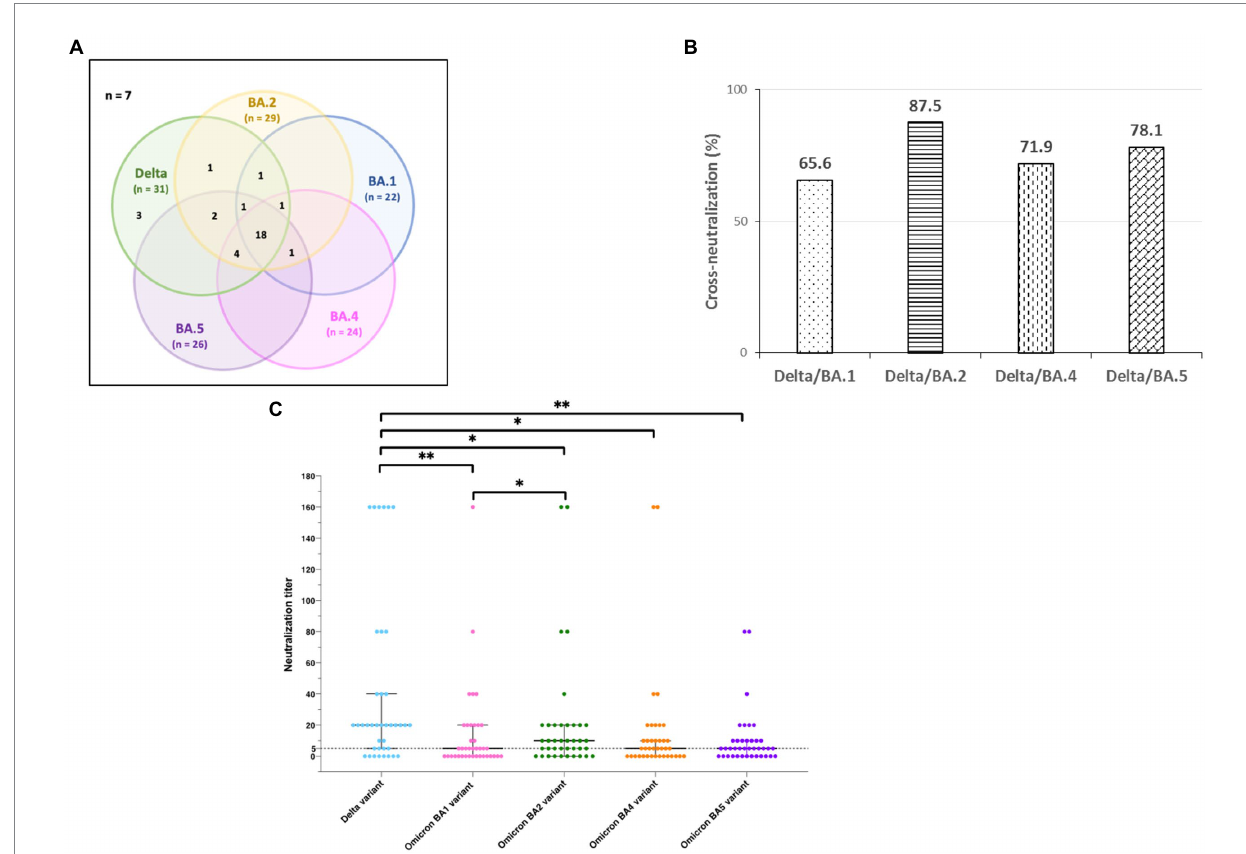
FIGURE 2 Neutralization of SARS-CoV-2 variants by sera from 39 kidney transplant recipients. (A) Profiles of SARS-CoV-2 variant neutralization and cross- neutralization by sera from 39 kidney transplant recipients. The cross-neutralizations are shown in a Venn diagram. Numbers in parentheses are the total numbers of sera that neutralized the variant. Seven sera had no neutralizing activity against the five SARS-CoV-2 variants, whereas 32 neutralized at least one variant. Eighteen neutralized all the variants. (B) Frequencies of cross-neutralization of Delta and different Omicron variants for the 32 sera that neutralized at least one variant. (C) Neutralization titers in the sera from 39 kidney transplant recipients according to the SARS-CoV-2 variant. The black bar represents the median value, and error bars represent the interquartile ranges of values. The black dashed line represents the cutoff for a detectable neutralization titer of 5. The neutralization titers against the five variants were compared using one-way ANOVA followed by Tukey’s multiple comparison test. * p < 0.05, ** p <